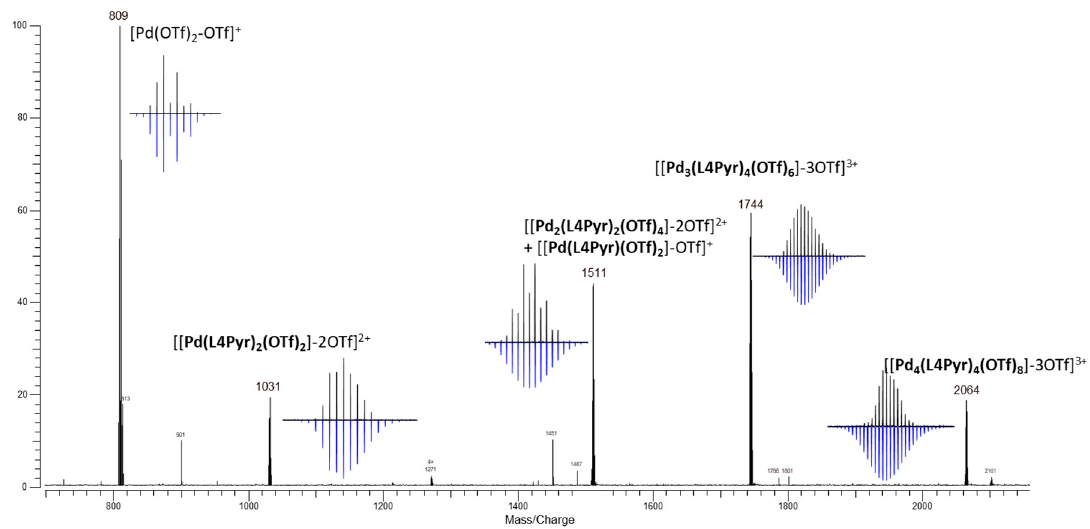
Figure 3. ESI-FTICR mass spectrum of metalla-macrocycle [ Pd 2 (L4Pyr) 2 (OTf) 4 ] in CH 2 Cl 2 /CH 3 NO 2 (9/1) (C = 10 − 3 M), in black experimental isotopic pattern, in blue theoretical isotopic pattern.